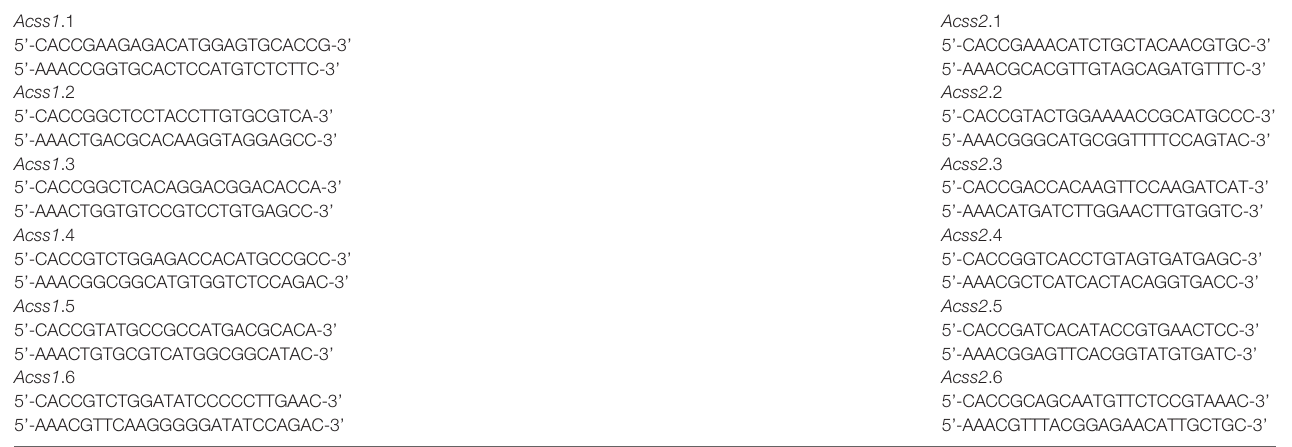
TABLE 2 | Guide RNA